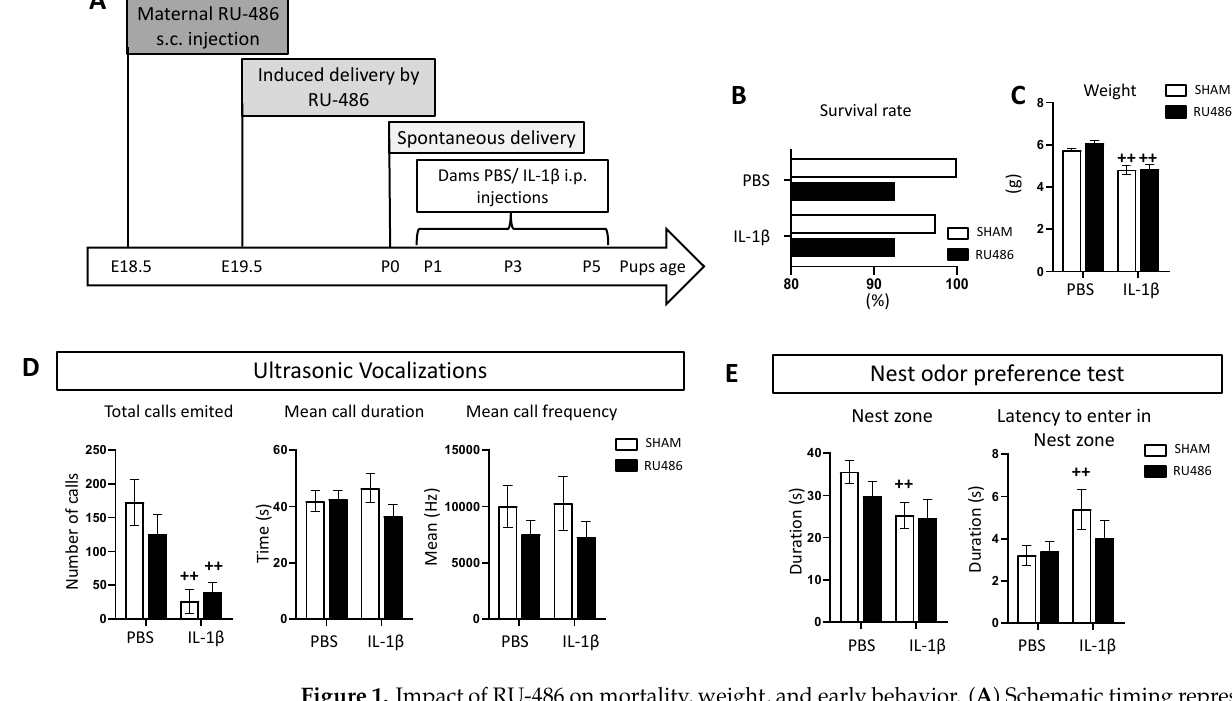
Figure 1. Impact of RU-486 on mortality, weight, and early behavior. ( A ) Schematic timing representation of the double-hit model of RU-486-induced delivery ± perinatal inflammation (IL-1 β injections). ( B ) Representation of survival rate (%) at P8 according to the mode of delivery and perinatal inflammation ( n = 50/group). ( C ) Mean weight (g) at P8 according to the mode of delivery and perinatal inflammation. ( D ) Ultrasonic vocalization test evaluating total calls emitted, mean call duration (s), and frequency (Hz) in SHAM vs. RU-486 animals and PBS vs. IL-1β animals ( n = 15/group). ( E ) Nest odor preference test at P8 evaluating maternal recognition. Results are presented as mean time spent in nest zone and mean latency time to enter the nest zone ( n = 15–20/group). Two-way analysis of variance (ANOVA) corrected by the Sidak test (++ p ≤ 0.01 comparing IL-1β vs. PBS).